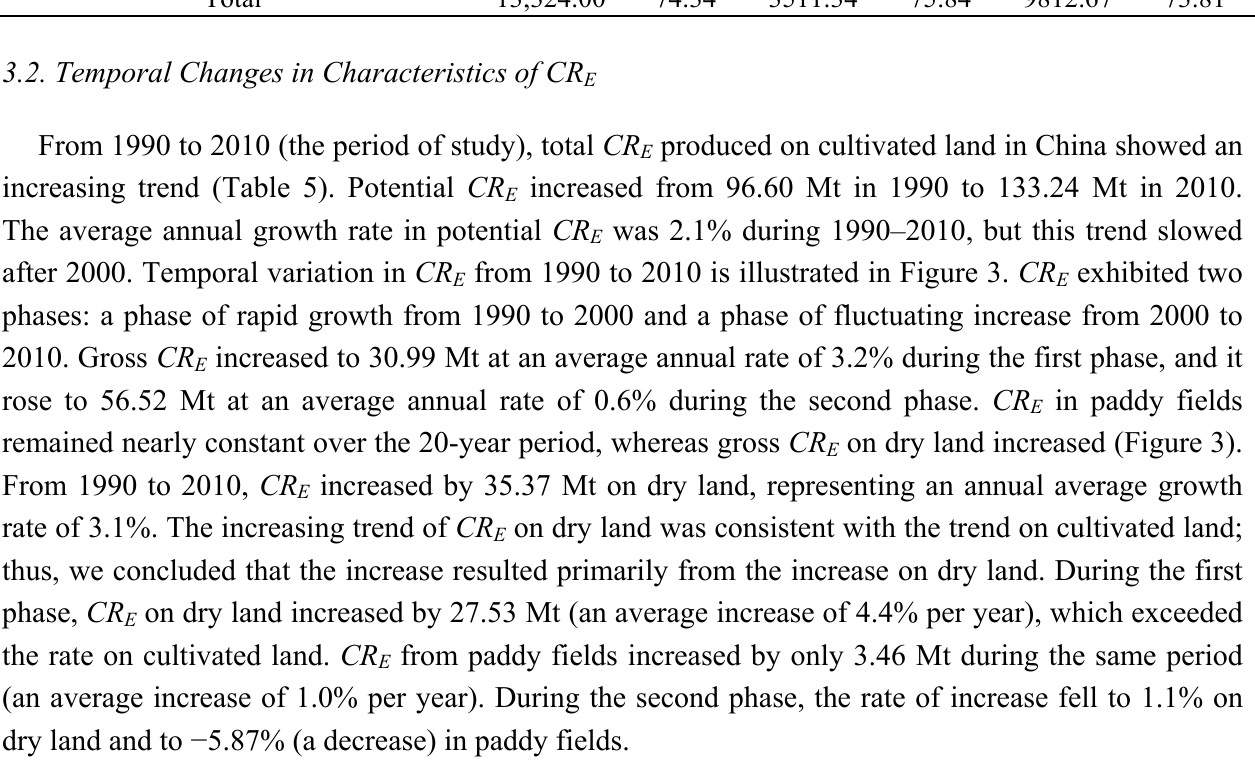
produced in different land-use E